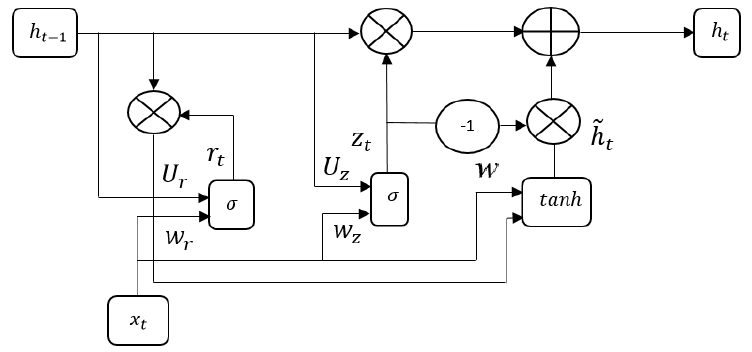
Figure 6. Architecture of the GRU model.